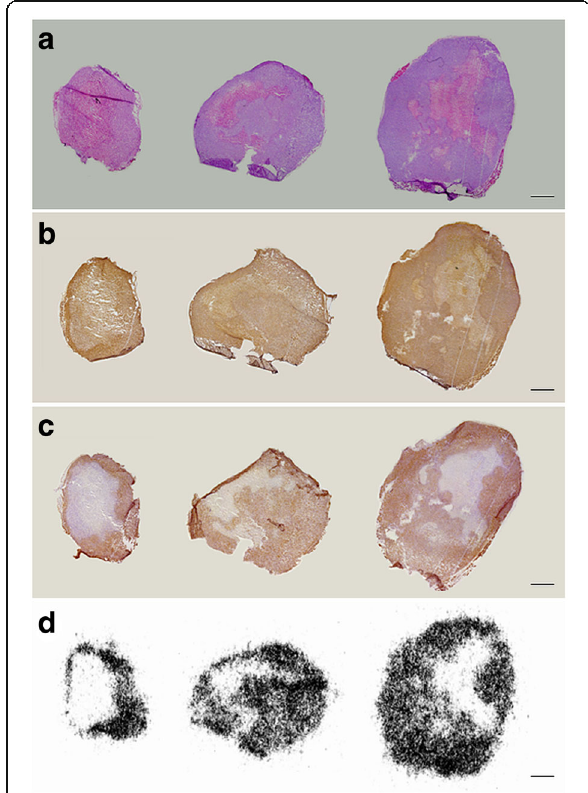
Fig. 5 Immunohistochemistry and autoradiography on representative MDA-MB-231 tumour sections (adjacent) obtained from three representative tumours used in this study. a Haematoxylin/eosin staining; b immunohistochemical detection of TG2; c TG2 mediated incorporation of BAP; d autoradiography using [ 18 F] 2 . Scale bars: 1